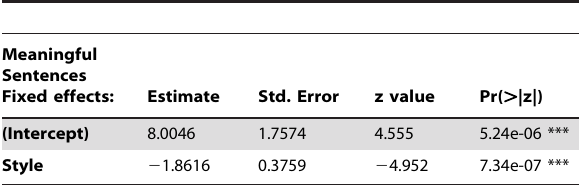
Table 2. Results of the linear mixed effects logistic regression on intelligibility data for all sentences.